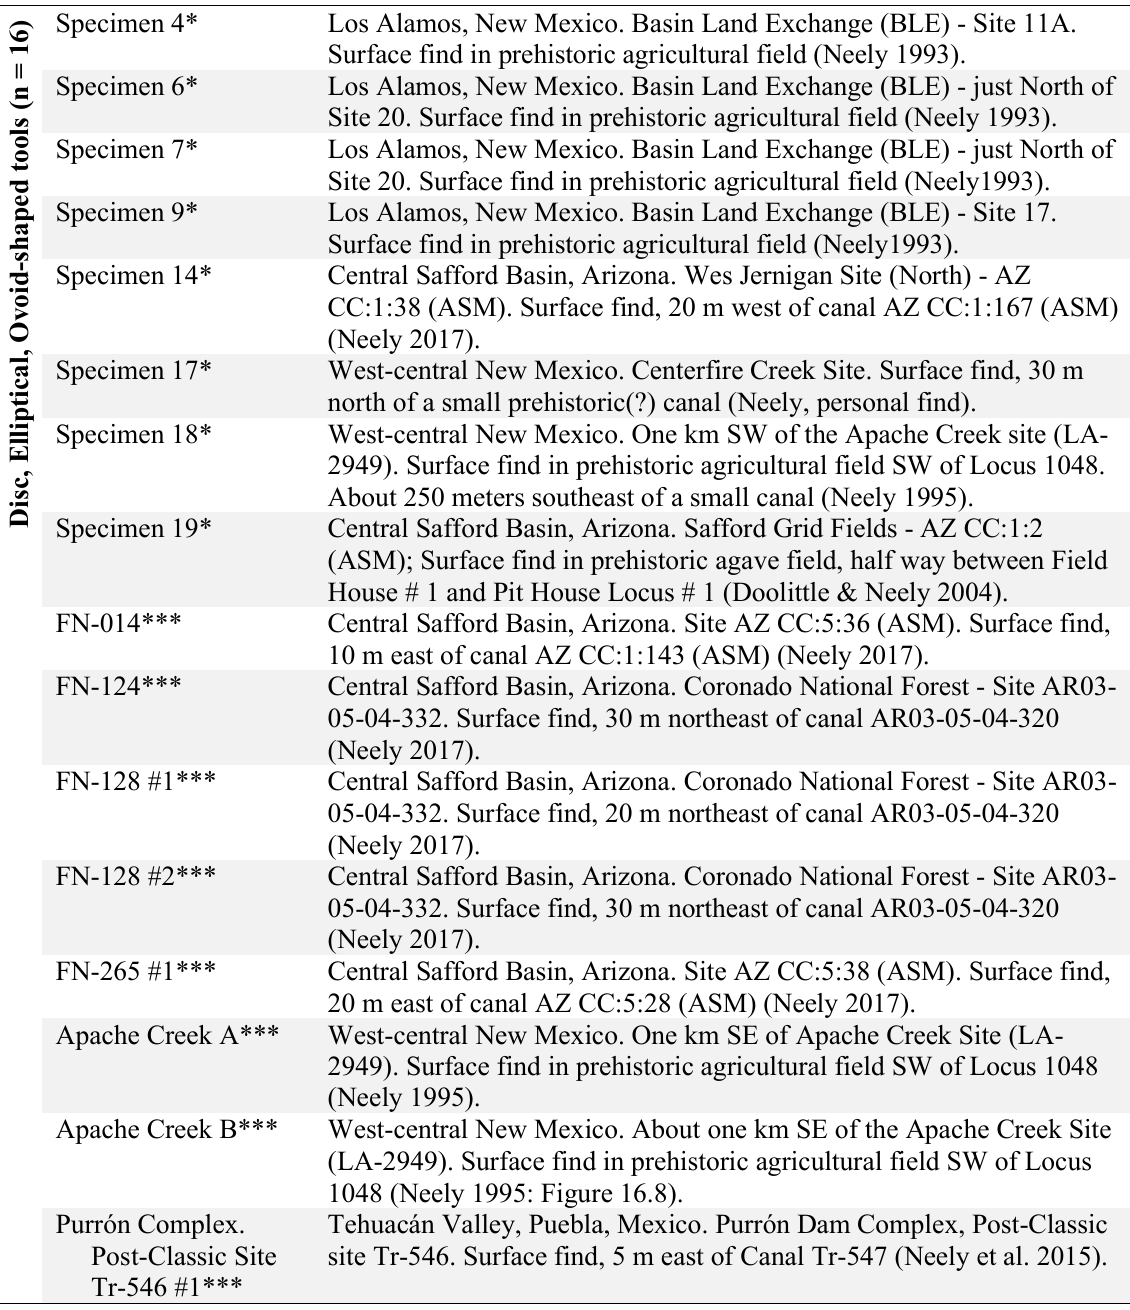
Table 4. Proveniences and Find Contexts of the Forty-Four Artifacts Analysed. Specimen numbers Specimen numbers having one asterisk were subject to detailed metric analyses. Specimen numbers with two asterisks represent artifacts from Woodson’s (1995; 1999) excavation. Specimen numbers with three asterisks represent tools documented in the field or gleaned from the literature. SPN or ID: Specimen number or